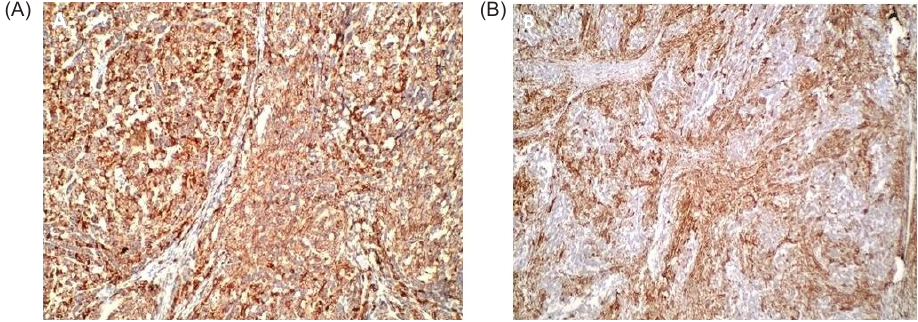
Figure 4: (A) Tumor cells are positive for vimentin on immunohistochemistry, 10× magnification. (B) Tumor cells are positive for WT-1 on immunohistochemistry, 10×